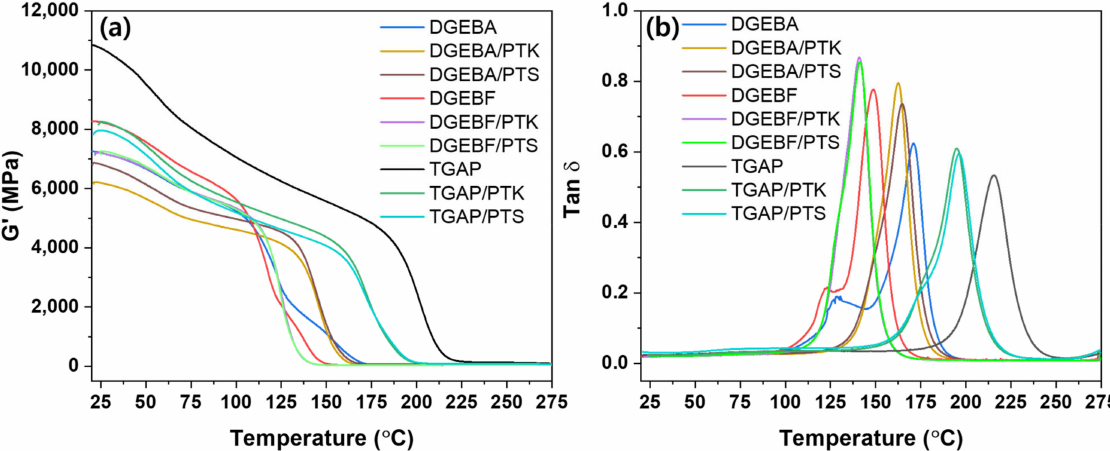
Figure 9. Dynamic mechanical properties of the prepared samples: ( a ) Storage modulus curves; ( b ) tan δ